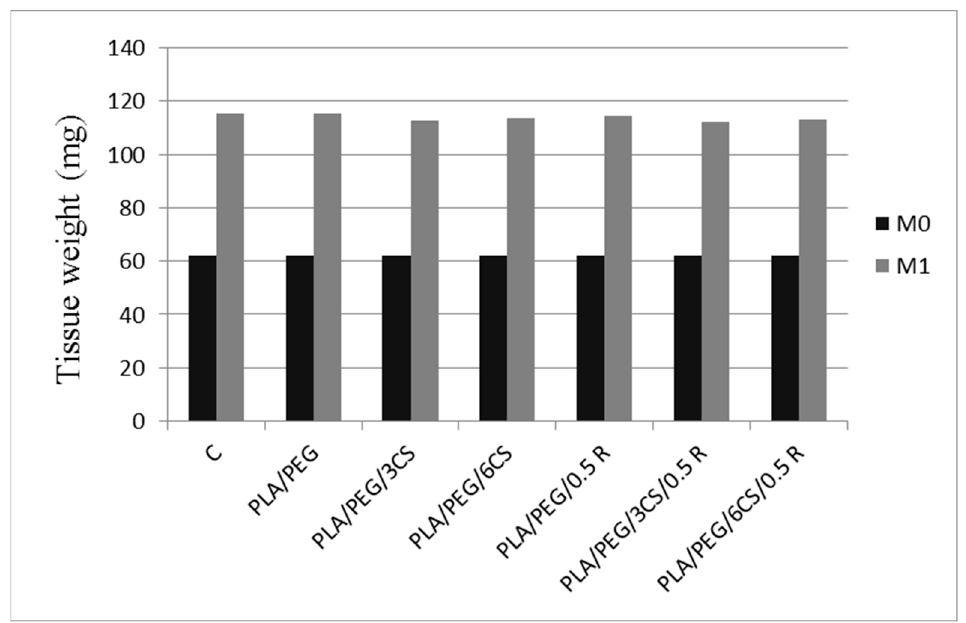
Figure 9. The influence of biocomposite implants on the granuloma’s tissue weight after seven days. Table 9. The influence of biocomposite implants administration on the elements of the leucocyte formula. Values were presented as mean ± S.D. for six animals in a